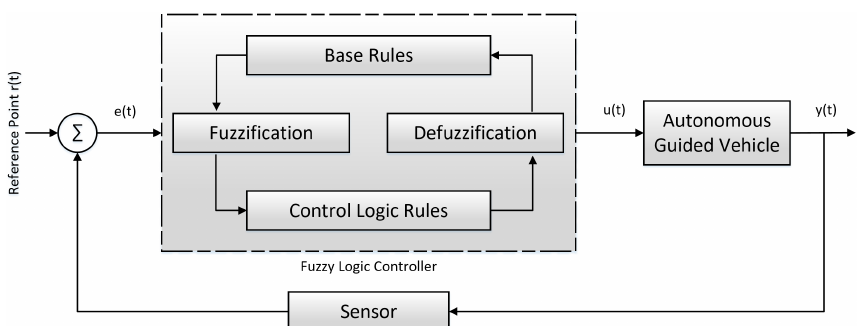
Figure 6. Block diagram of the Fuzzy Logic Controller for an autonomous guided vehicle